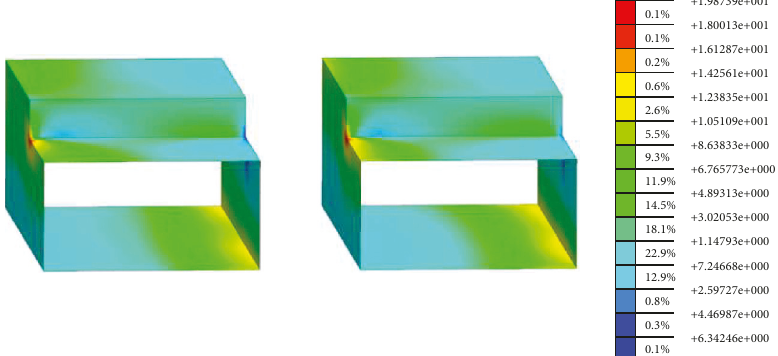
Figure 13: Principal stress cloud diagram of the